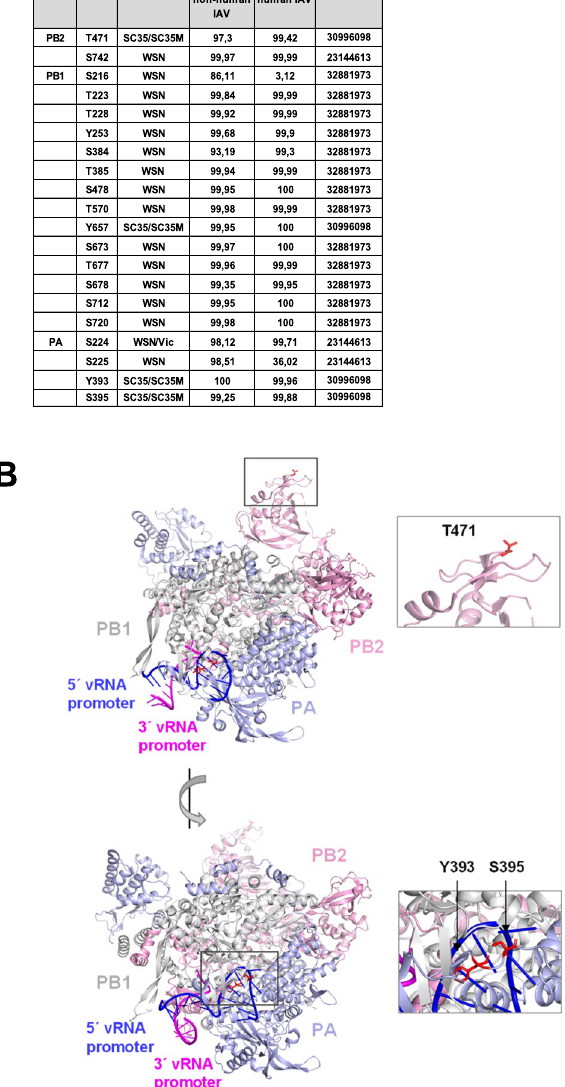
Figure 1. Summary of IAV phosphorylation sites in the polymerase subunits. ( A ) Phosphorylation sites of polymerase subunits occurring in vivo are listed, whereas phosphorylations detected only by in vitro experiments were not included. The virus strains in which the modifications were detected are indicated (WSN: A/WSN/1933 (H1N1); Vic: A/Victoria/3/75 (H3N2); SC35: A/Seal/Massachusetts/1/80 (H7N7); SC35M: A/Seal/Massachusetts/1/80 (H7N7) mouse-adapted). ( B ) The position of PB2 T471 and PA Y393, S395 phosphorylation sites within the polymerase complex are shown in red, the PB2, PB1, and PA subunits and